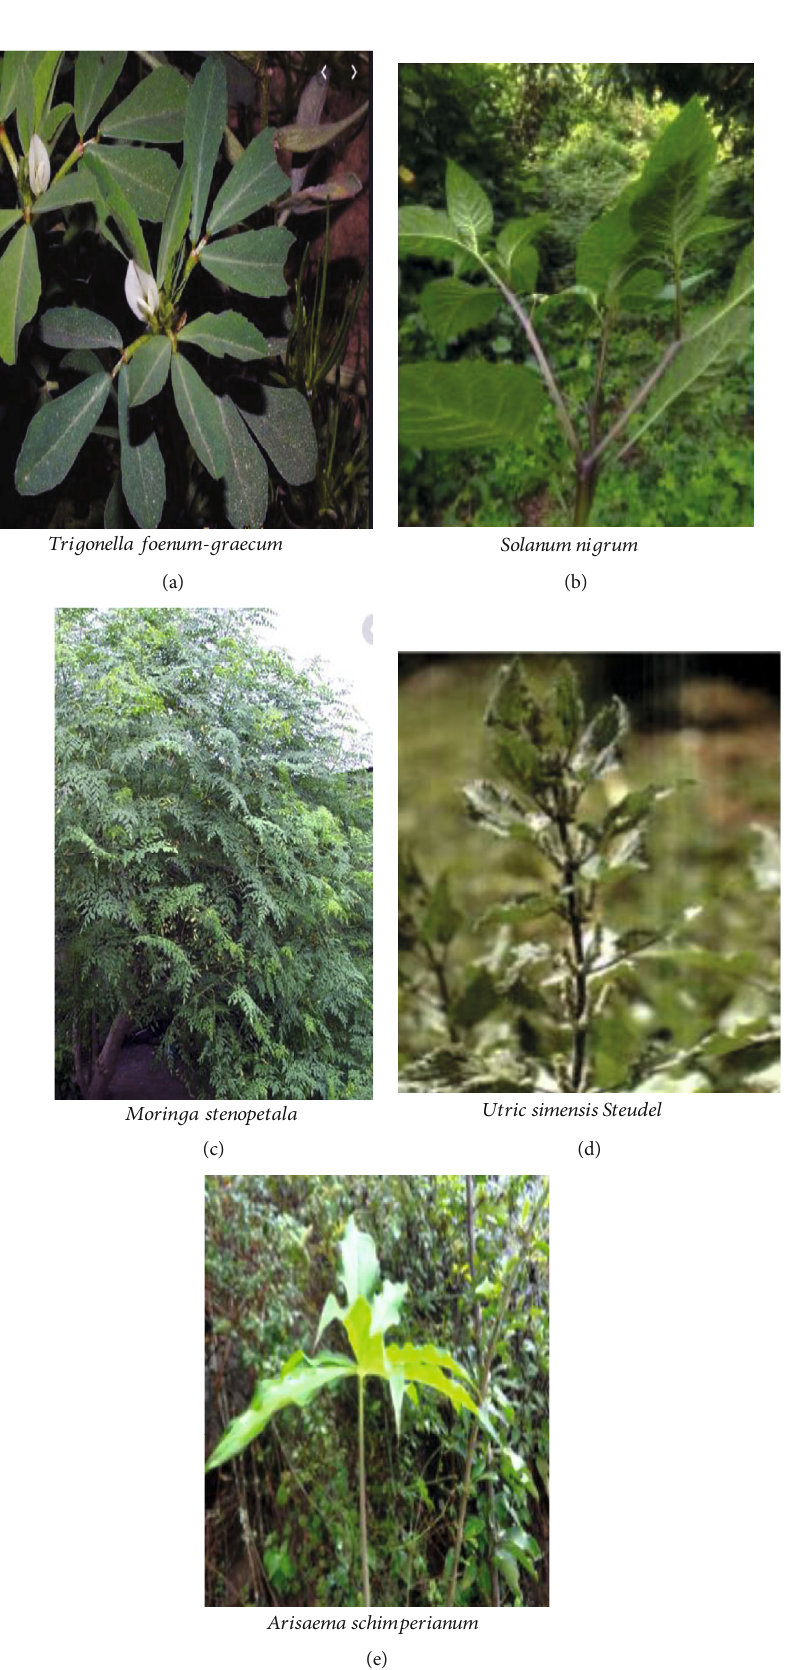
Figure 1: Commonly used wild edible leaves (a –